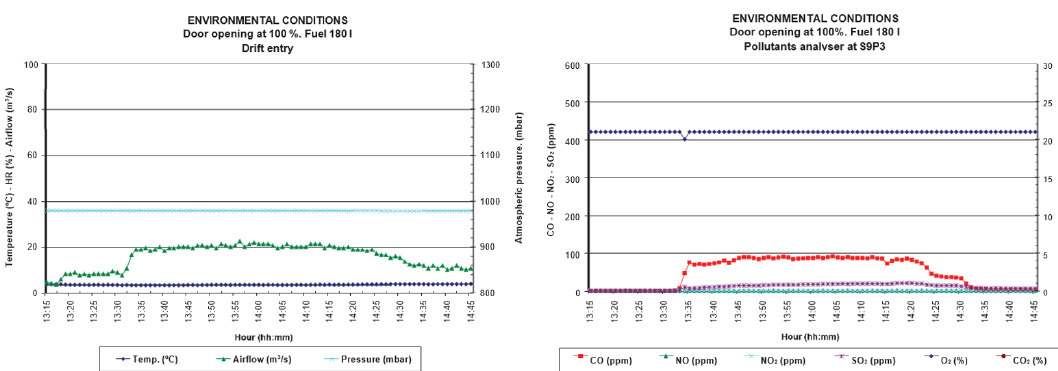
Figure 8. EvolutioSn of the environmental conditions over time; test 4. Figure 9. Evolution of the environmental conditions over time; test 5. The dry temperature did not present any change with respect to the outside temperature except in Scenario 5, the test with the biggest fire load, having a small variation over time. On the other hand, the airflow was significantly affected by the fire evolution over time when the door was fully open. There was a variation between 12.5 m 3 /s and 20 m 3 /s for a load of 180 L of fuel, while, for loads of 360 and 540 L, the flow increased to 30 m 3 /s, representing a 60% increase for E3 scenario and between 150 and 200% for E4 and E5. This variation occurred after 960 s from the beginning of the fire in E3, while it happened at 450 and 420 s for E4 and E5, respectively. This phenomenon is due to a natural pull of the ventilation in the same direction of the flow due to a temperature increase once the fire reaches its maximum development. Then, as the fire loses power, the additional airflow is gradually reduced until it reaches the initial situation. In addition, it was also observed that it acted as a resistance during a brief period of time at an early stage of the fire, reducing the airflow.